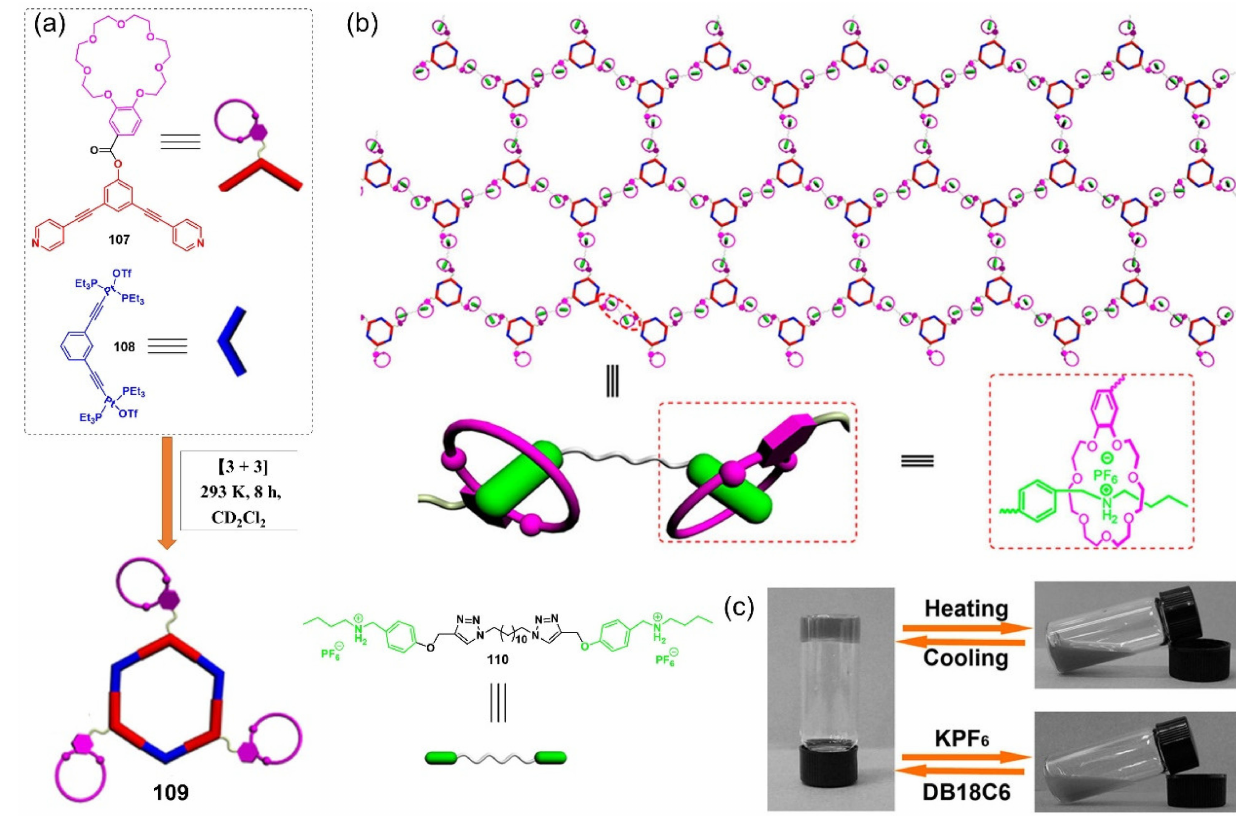
Figure 48. ( a ) Self-assembly of B21C7-functionalized discrete metallacyclic hexagon 109 and ( b ) cartoon representation of the formation of a cross-linked 3D supramolecular polymeric network from self-assembly of hexagon 109 and bis-ammonium salt 110 . ( c ) Reversible gel − sol transitions of supramolecular polymer gels. Reprinted with permission from Ref. [129]. Copyright (2014), American Chemical